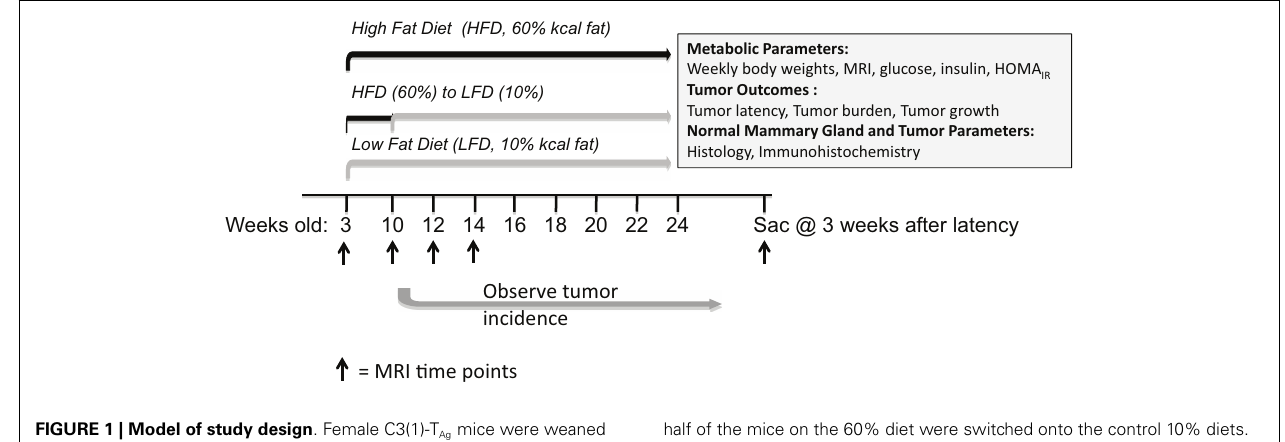
FIGURE 1 | Model of study design . Female C3(1)-T Ag mice were weaned onto control low-fat 10% kcal derived from fat (“10%”) or obesogenic 60% kcal derived from fat (“60%”) diets at 3weeks of age. At 10weeks of age,